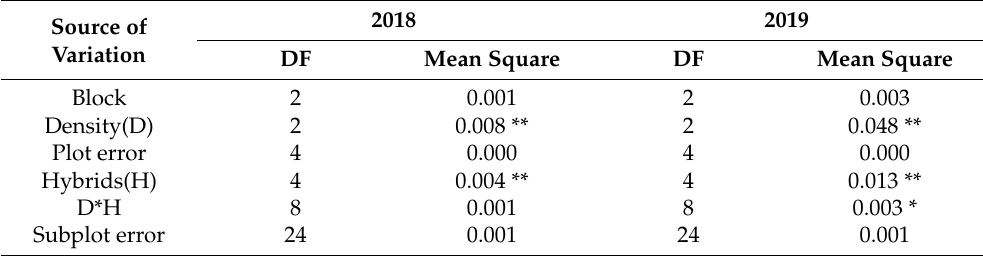
Table 6. ANOVA analysis of seed dehydration rate before physiological maturity.